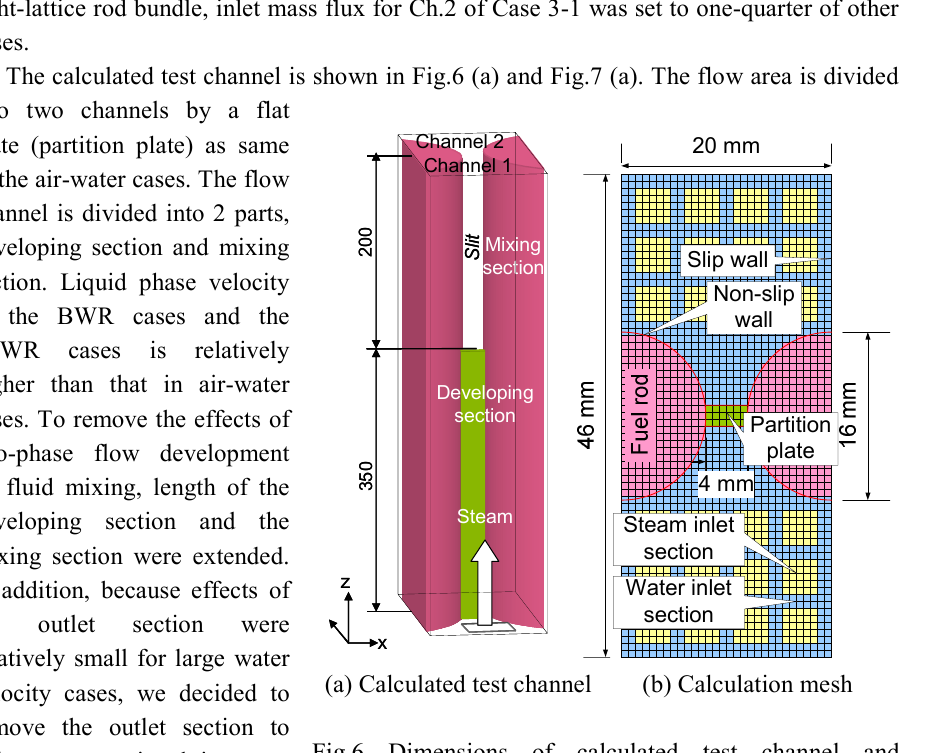
Fig.6 Dimensions of calculated test channel and calculation meshes in channel cross section for BWR